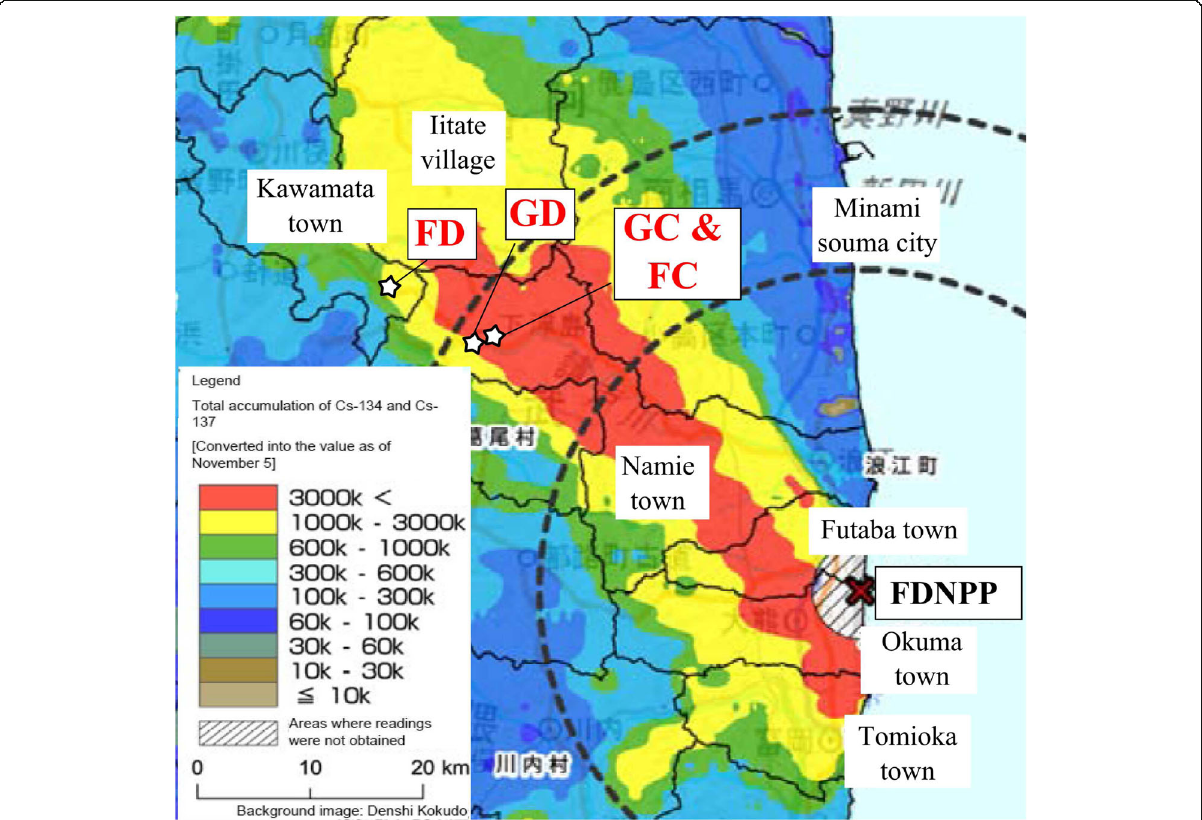
Fig. 1 The four sampling locations in this study plotted over the deposition density map for 134,137 Cs obtained by the Japanese government (Ministry of Education, Culture, Sports, Science and Technology, Japan (MEXT) 2011). The radius of dotted outer circle is 30